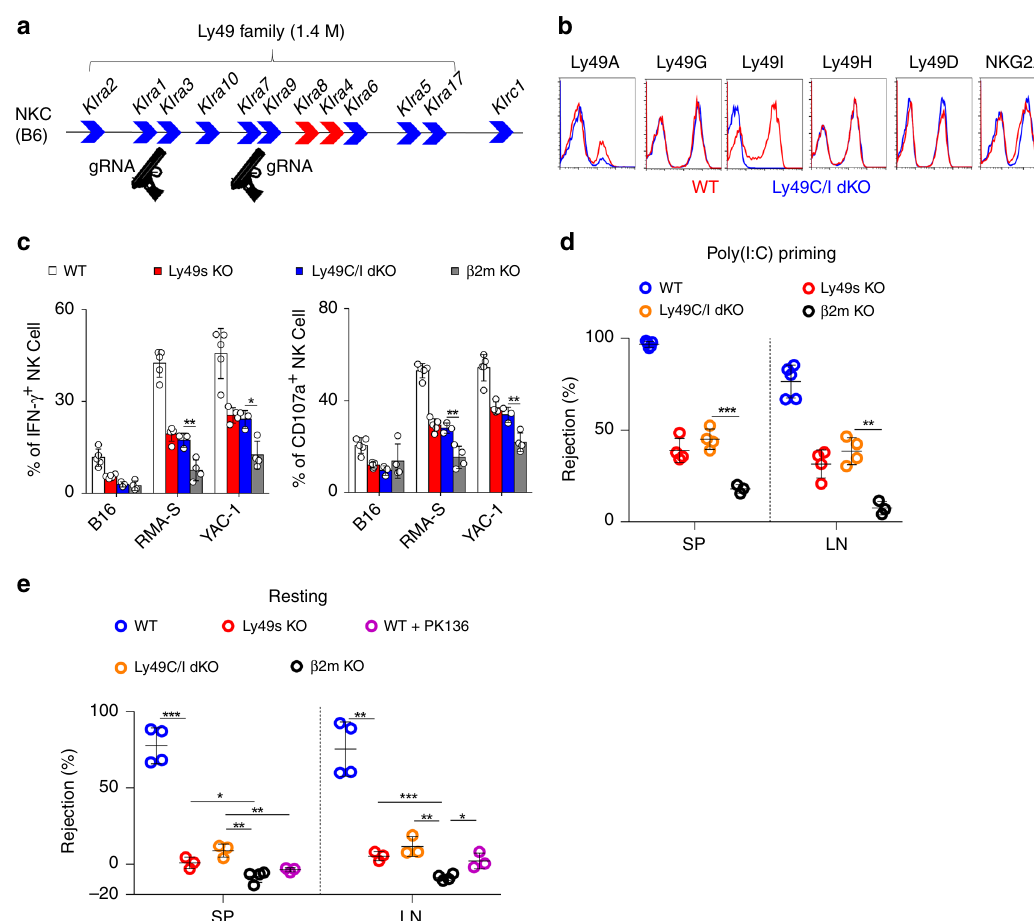
Fig. 4 Deletion of Ly49C/I mimics the defective NK-cell activity in Ly49 family-de fi cient mice. a Diagram of the indicated genes in the NKC locus. Guns denote CRISPR gRNAs targeting Klra3 and Klra9 . b Flow cytometry analysis of the expression of the indicated receptors on splenic CD3 − NKp46 + NK cells from WT (red line) and Ly49C/I dKO (blue line) mice. c Poly(I:C)-primed splenocytes from the indicated mice were stimulated with tumour target cells. Percentages of IFN- γ + (left panel) and CD107a + (right panel) gated CD3 − NKp46 + NK cells were analysed. d In vivo rejection of β 2M-de fi cient splenocytes (similar to Fig. 3a). e In vivo rejection of β 2M-de fi cient splenocytes (similar to Fig. 3d). Each symbol represents an individual mouse. Data shown represent two ( e ) or at least three ( c , d ) independent experiments. Mean± SD is shown. * p < 0.05, ** p < 0.01, *** p < 0.001 and **** p < 0.0001. Unpaired Student ’ s t -tests (two-tailed) was used to calculate these values. Source data are provided as a Source Data fi